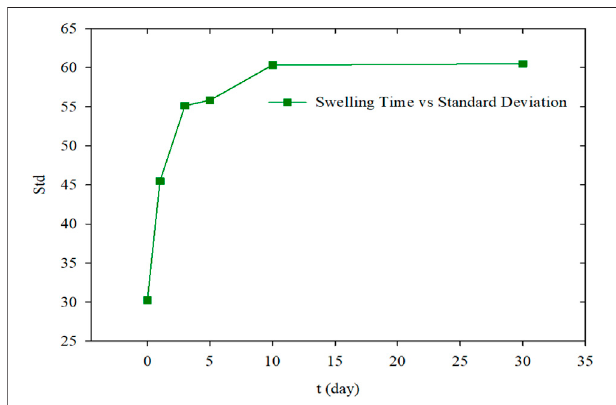
FIGURE 10 | The average size of PMs with different hydration times.